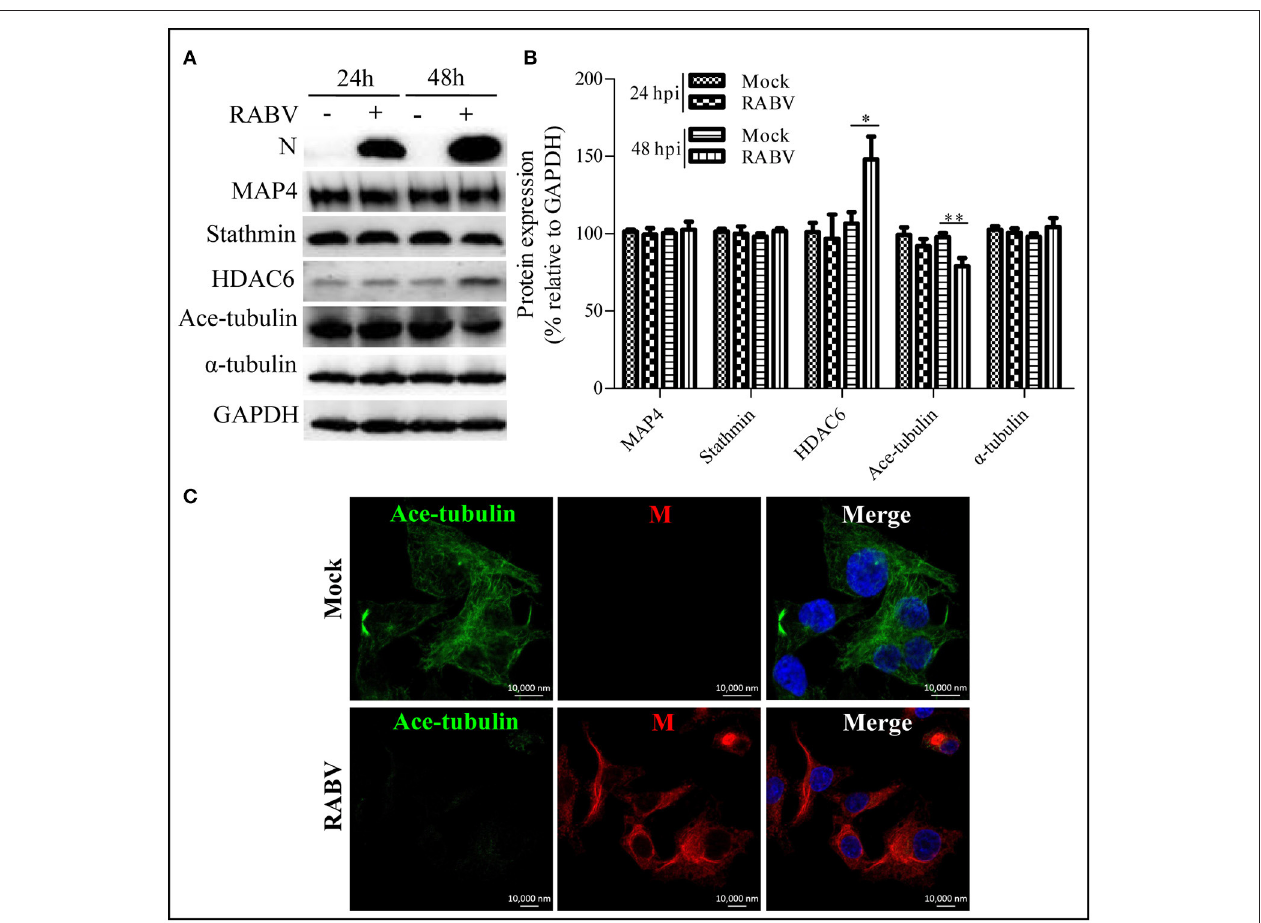
FIGURE 3 | Effects of an RABV infection on the acetylated modification of microtubules. (A) N2a cells were infected with RABV or not. At 24 and 48 hpi, the cells were lysed and subjected to Western blotting to determine the expression of the viral N protein, MAP4, stathmin, HDAC6, ace-tubulin, α -tubulin, and GAPDH (as loading control). (B) The relative expression levels of MAP4, stathmin, HDAC6, ace-tubulin, and α -tubulin were calculated by normalizing to that of GAPDH, respectively. (C) The distribution of the viral M protein (red) and ace-tubulin (green) in RABV-infected or mock-infected N2a cells at 24 hpi. The cell nuclei (Nuc) stained with DAPI (blue). Scale bars, 10,000 nm. The data are presented as the means ± SD ( n = 3; *represents P < 0.05, **represents P <